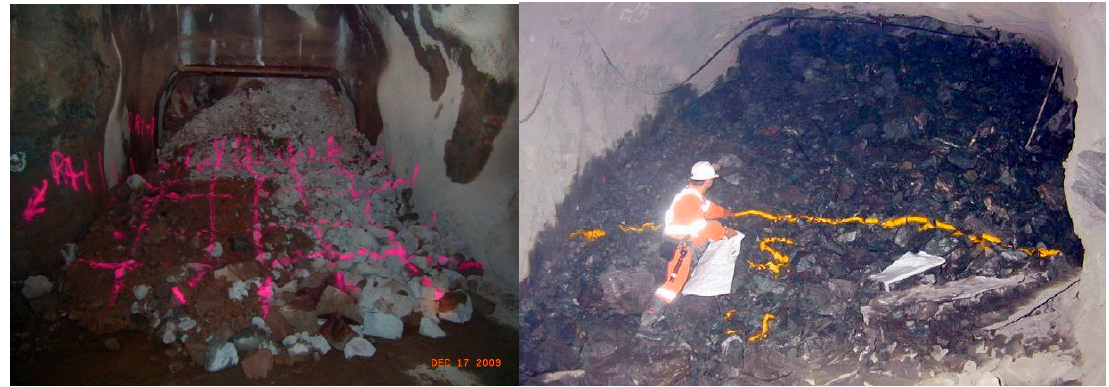
Figure 7. Drawpoint with sampling grid ( Left ) and sample collection ( Right ).